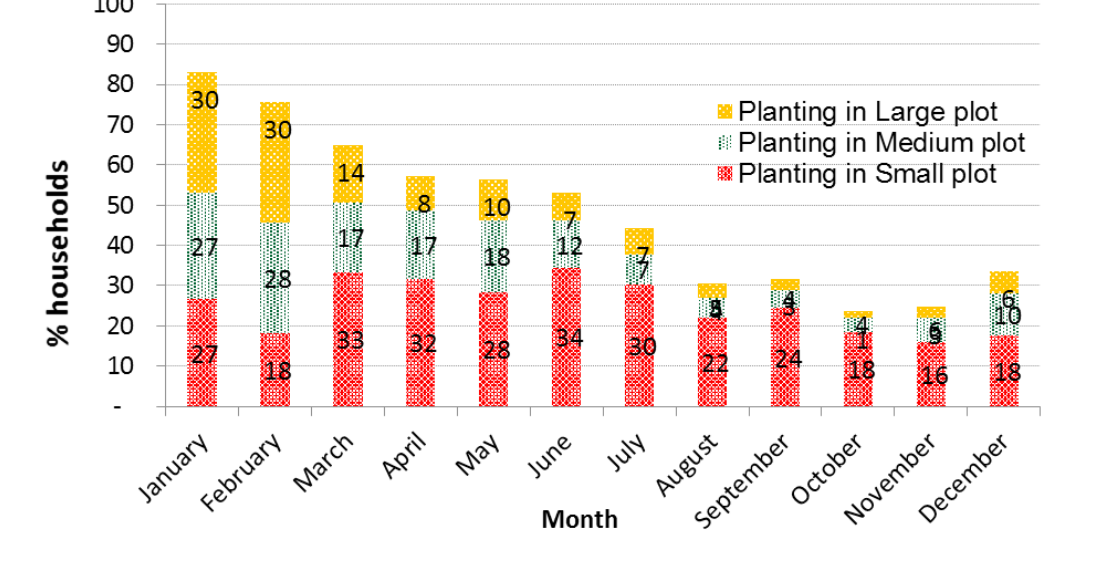
Figure 7: Households planting OFSP during the year in (%)